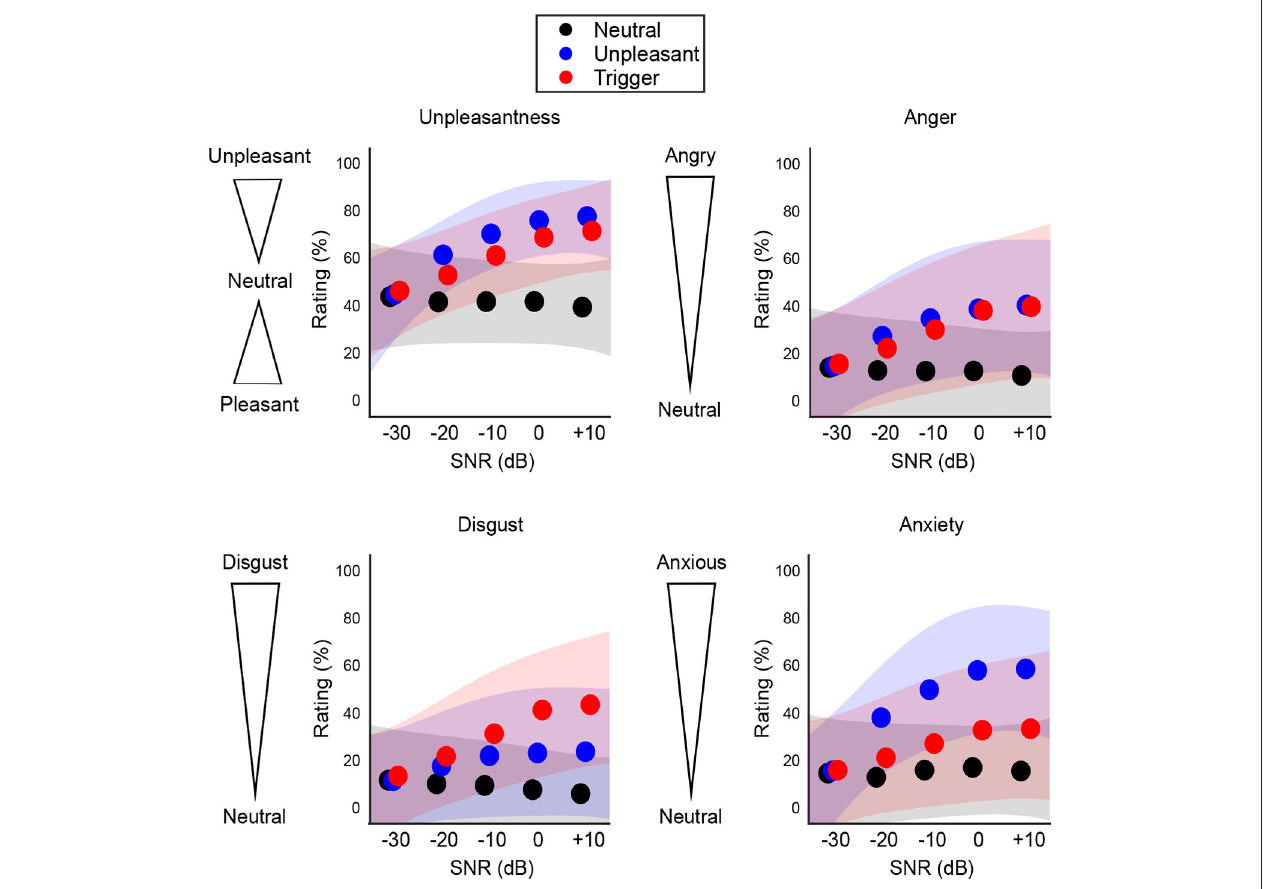
FIGURE 4 | Population results ( N = 300) for subjective ratings of each sound category. Shaded areas represent ± 1 standard deviation from the mean fit. The aversive sounds (blue and red) show a curvilinear